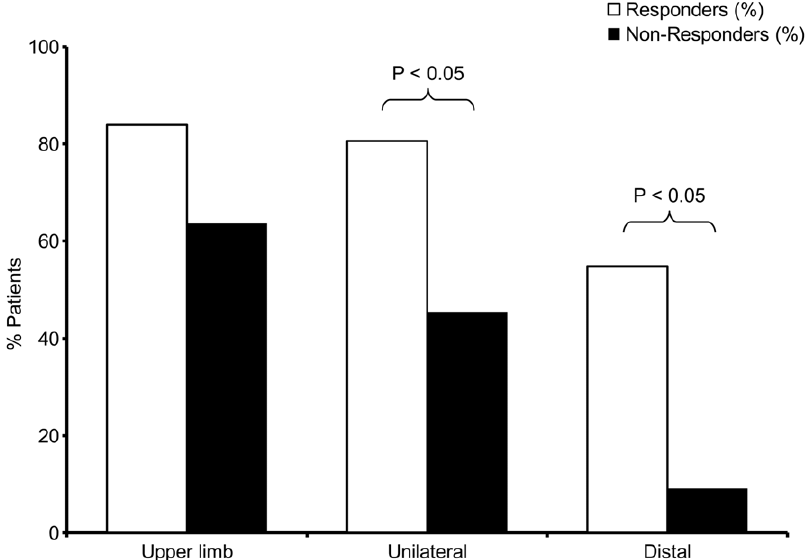
Figure 1. Responders (white bars) had the typical clinical phenotype of MMN, namely upper limb, unilateral, and distal onset weakness.